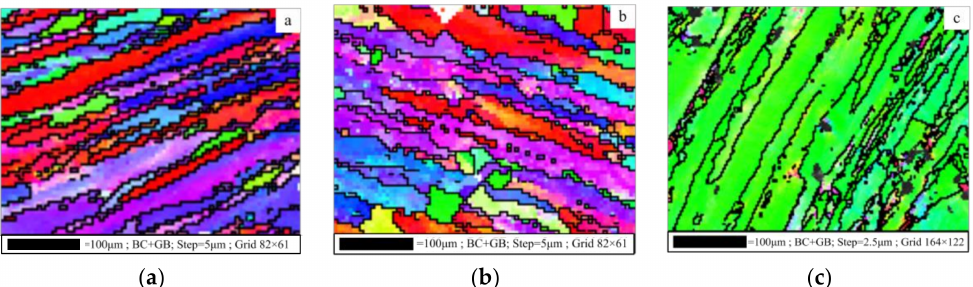
Figure 13. Microstructure of aluminum alloy 7050-T7451 in ND at different strain rates after impact shear: ( a ) 2.5 × 10 4 s − 1 ; ( b ) 3.5 × 10 4 s − 1 ; ( c ) 4.5 × 10 4 s − 1 .